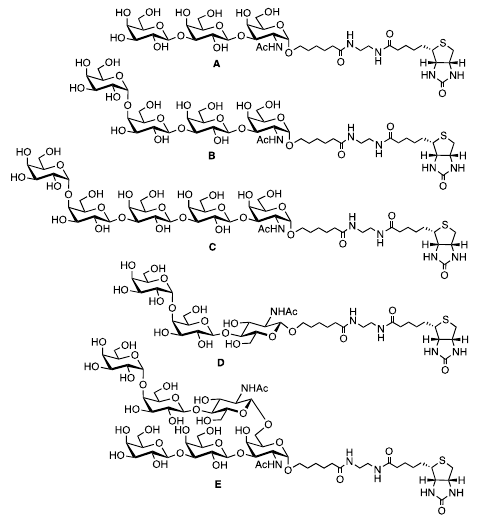
Figure 2. Synthetic target oligosaccharides from E. granulosus.